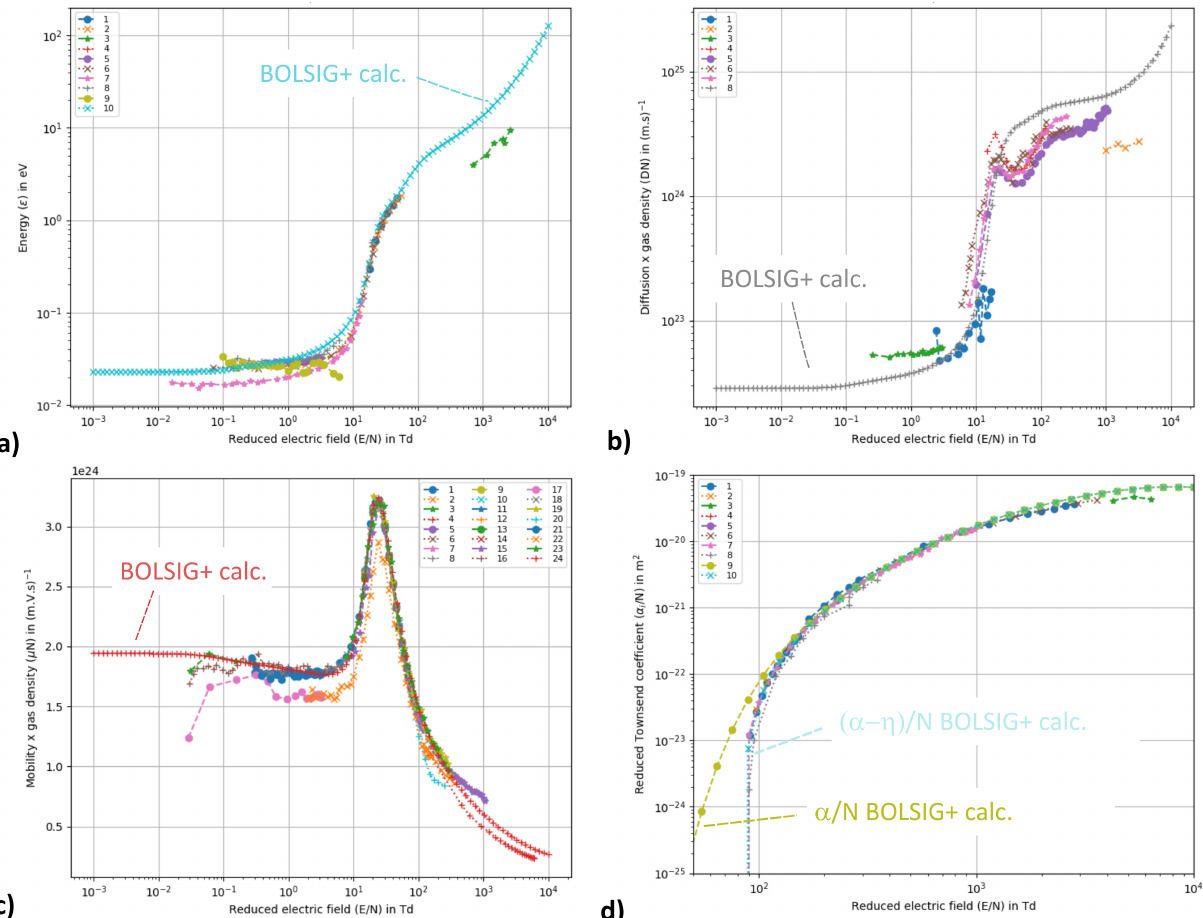
Figure 11. Swarm parameters calculated using the online Boltzmann solver for a pure CO 2 gas using the Biagi database [80,198] and comparison with experimental swarm measurements [133,135,199–219] from Dutton [132], ETHZ [134], Heidelberg [154], LAPLACE [149] and UNAM [150] databases as a function of reduced electric field. The computed quan- tities are: ( a ) characteristic electron energy, ( b ) product of the gas number density and electron diffusion coefficient, ( c ) product of the gas number density and electron mobility coefficient, ( d ) Townsend